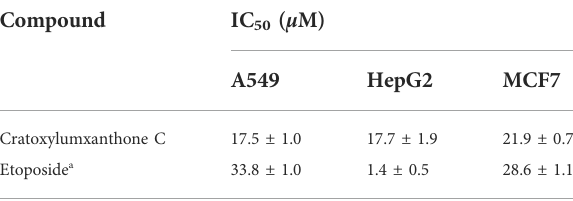
TABLE1CytotoxicitiesofcratoxylumxanthoneCagainstthreehuman cancer cell lines.